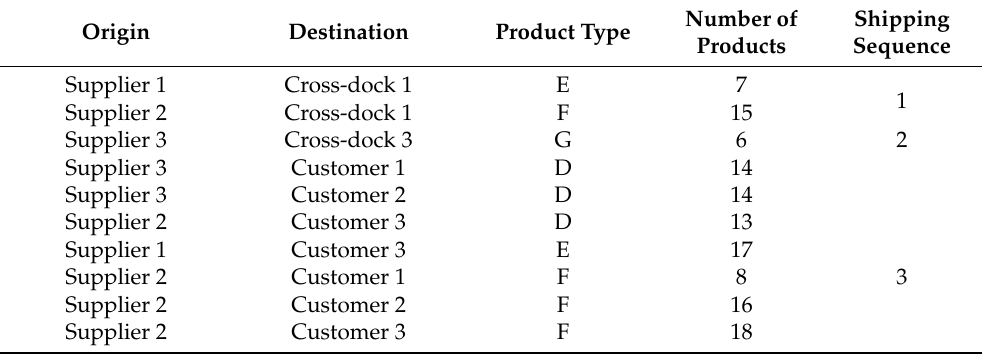
Table 17. Truck transport sequence 1 with NSGA-II algorithm for sample problem